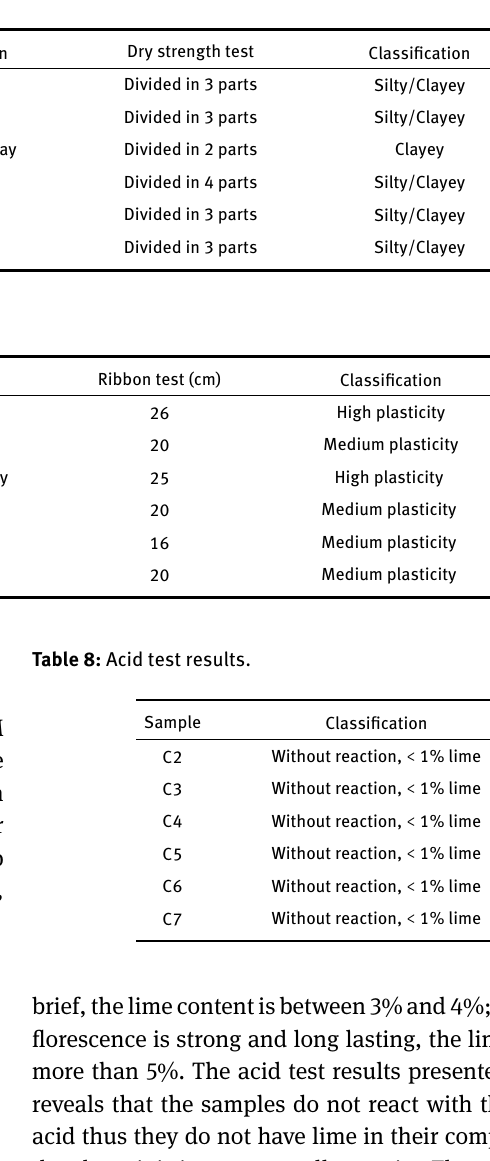
Table 6: Adhesion and dry strength test results.